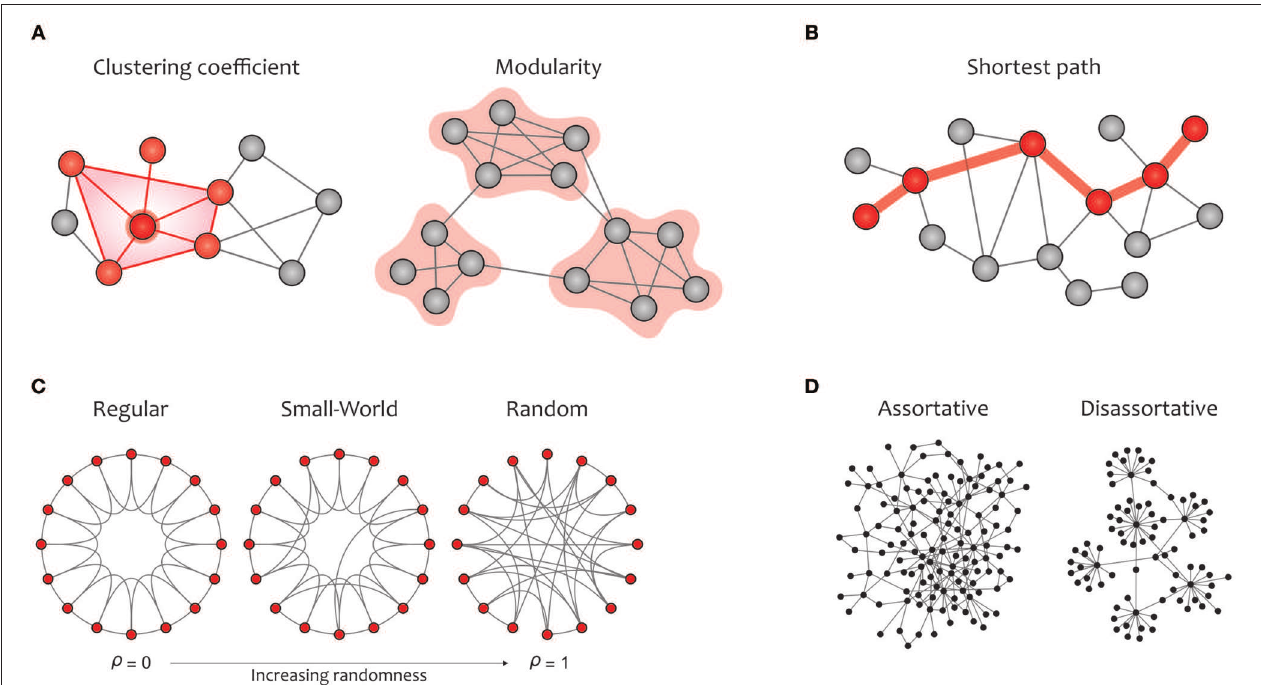
FIGURE 4 | Summary of global graph measures. (A) Segregation measures include clustering coefficient, which quantify how much neighbors of a given node are interconnected and measures the local cliquishness (i.e., the extent to which the neighbors of a node can build a complete graph); modularity, which is related to clusters of nodes, called modules, that have dense interconnectivity within clusters but sparse connections between nodes in different clusters. On the one hand, dense communications within a certain module increase the local clustering and, consequently, enhance the efficiency of information transmission in the given module. On the other hand, a few connections between different modules integrate the global information flow, which is associated with a reduction in the average path length in the graph (B) Integration measure include characteristic path length, which measures the potential for information transmission, determined as the average shortest path length across all pairs of nodes. (C) A regular network (left) displays a high clustering coefficient and a long average path length, while a random network (right) displays a low clustering coefficient and a short average path length. A small-world network (middle) illustrates an intermediate balance between regular and random networks (i.e., they consist of many short-range links alongside a few long-range links), reflecting a high clustering coefficient and a short path length. (D) The assortativity index measures the extent to which a network can resist failures in its main components (i.e., its vertices and edges). Notably, communication between hubs in assortative networks leads to covering each other’s activities when a particular hub crashes, but the performance in disassortative networks will drop sharply due to the presence of vulnerable